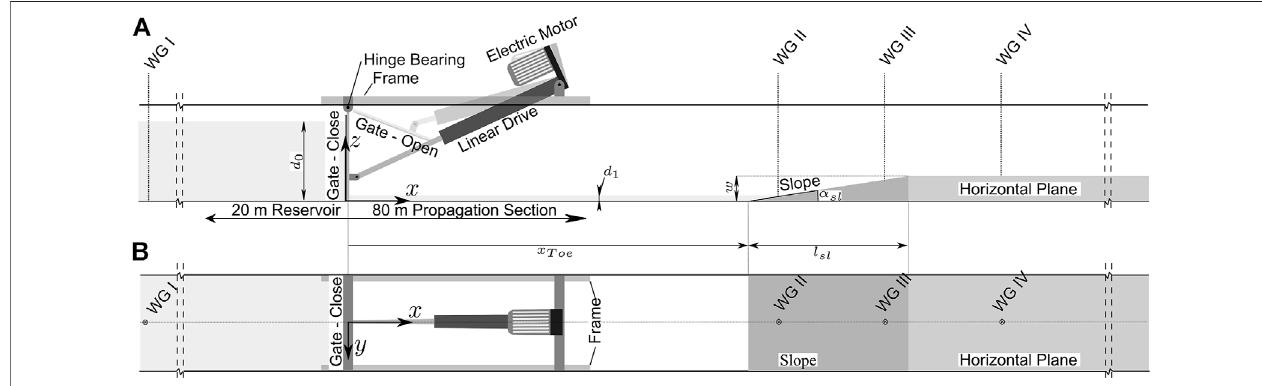
FIGURE 2 | Dam-break facility equipped with a fully controllable gate and four wave gauges in side- (A) and top-view (B) . The composite bathymetry and the parameters describing its geometry are indicated.